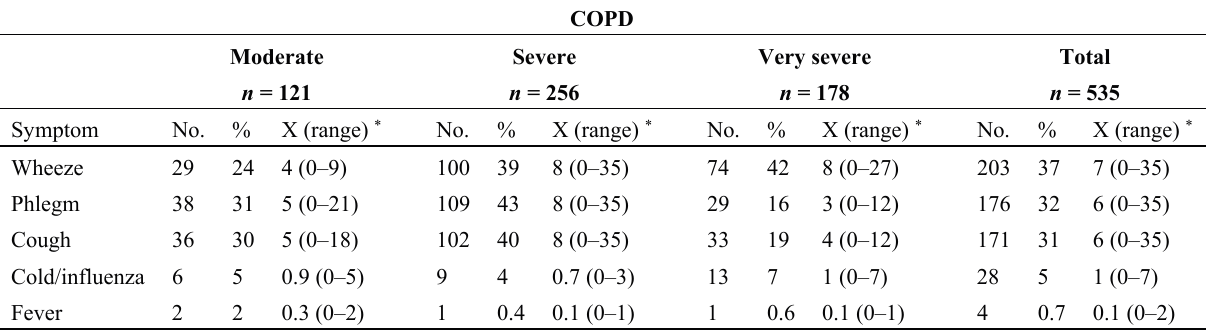
Table 2. Prevalence of symptoms by chronic obstructive pulmonary disease (COPD) severity status during the study